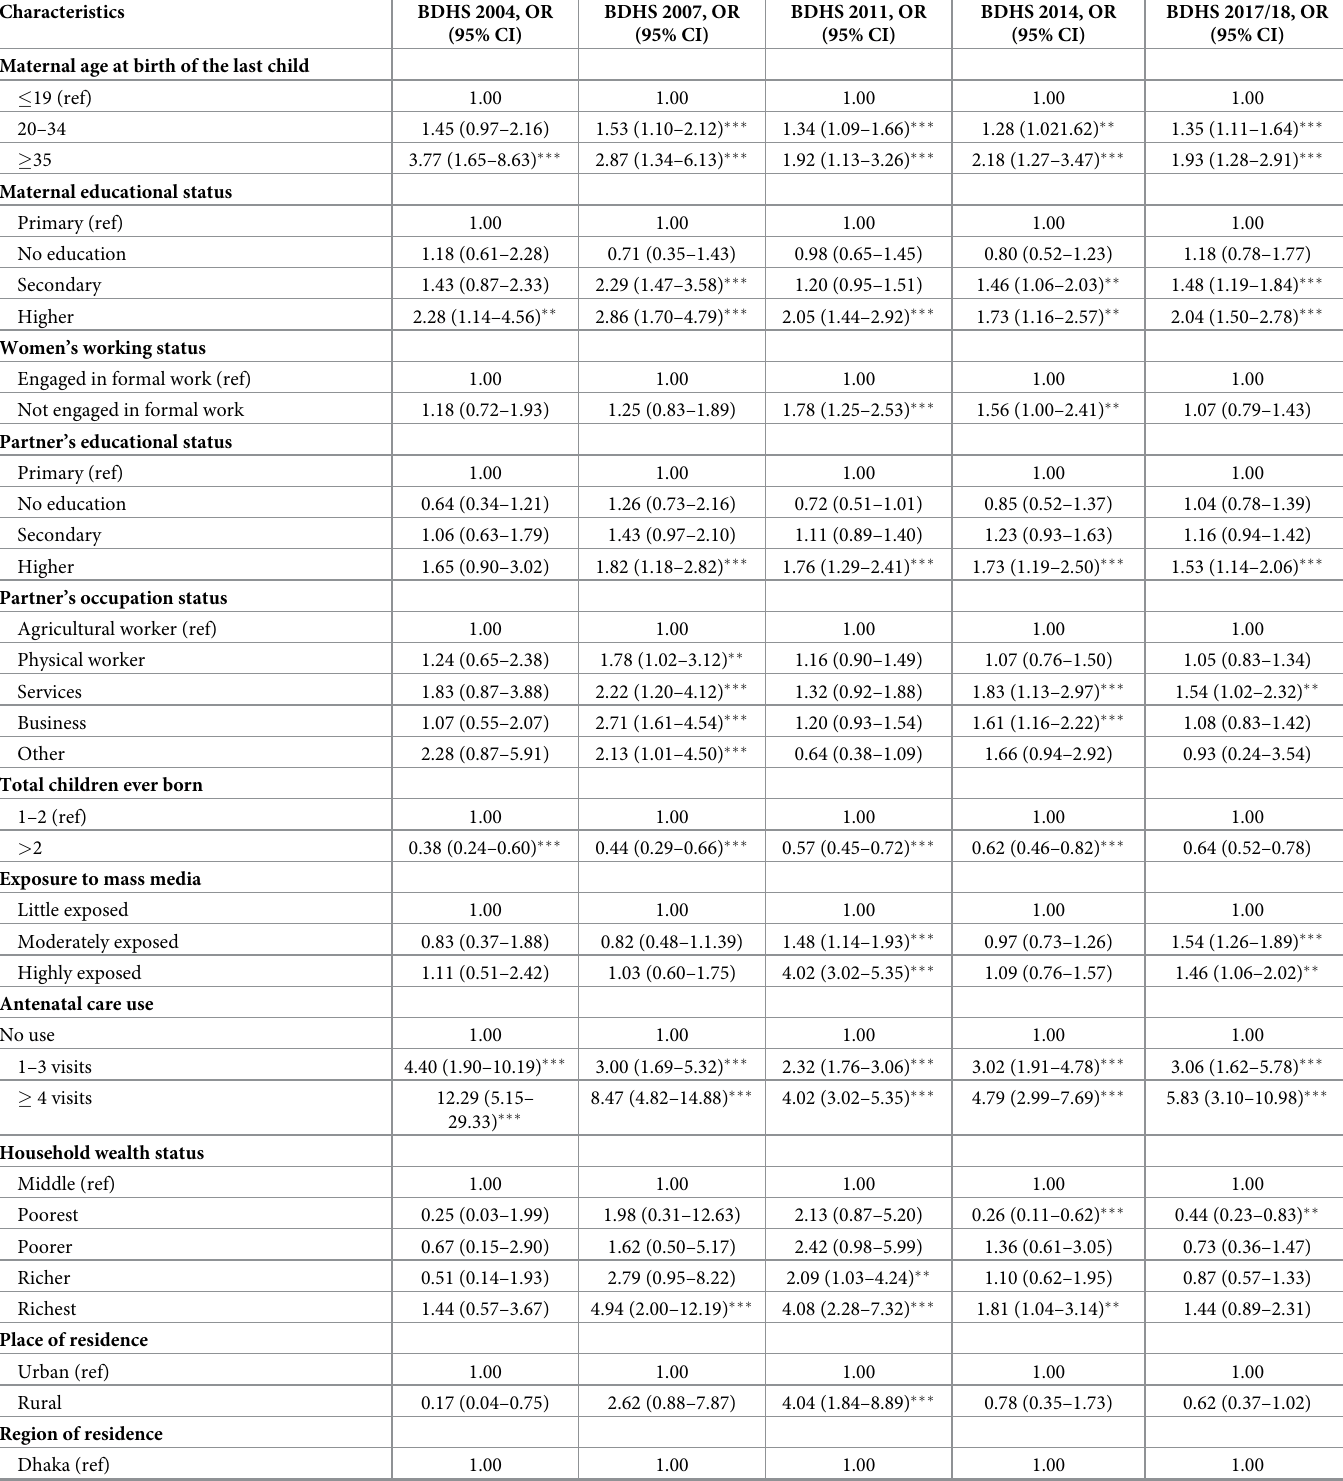
Table 3. Multilevel logistic regression models for the association of caesarean delivery with socio-demographic characteristics and the interactions of the working status and wealth quintile with place of residence at five-time points (BDHS Surveys: 2004, 2007, 2011, 2014, 2017/18).